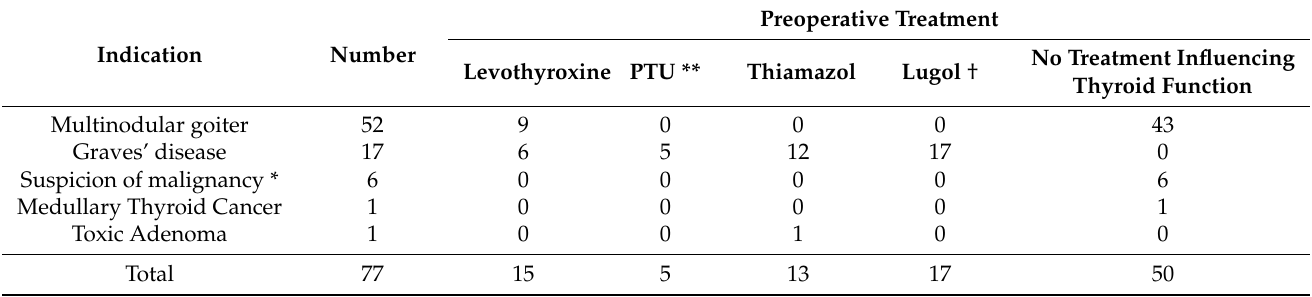
Table 1. Indications for surgery, patient characteristics, and preoperative treatment.